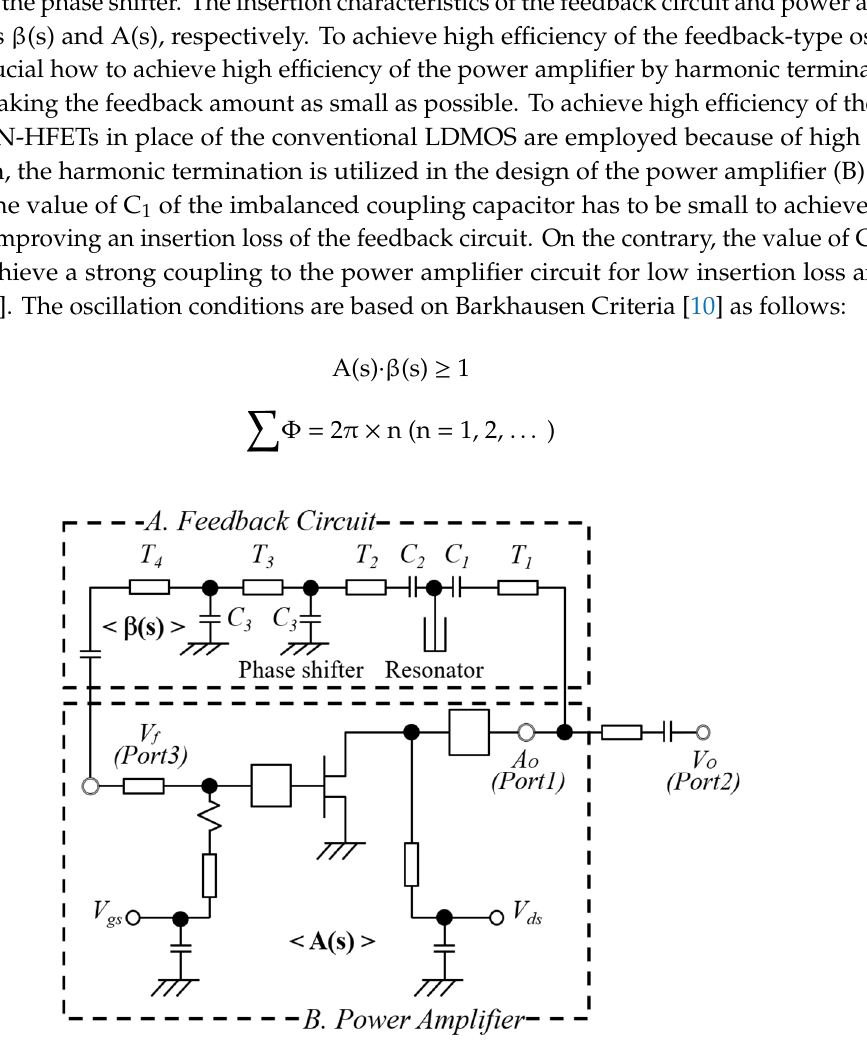
Figure 1. Schematic diagram of the feedback oscillator.